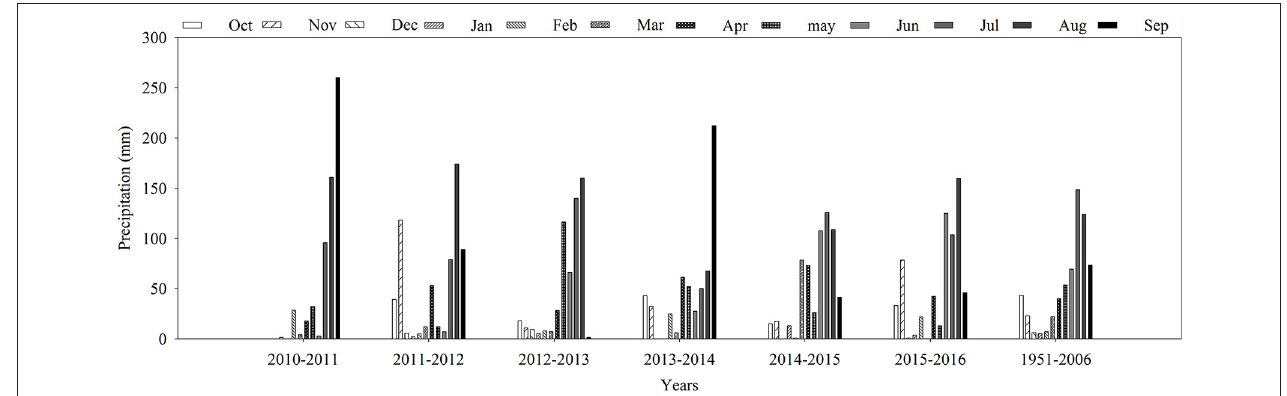
FIGURE 1 | Annual precipitation by month (October to September) during the six wheat-maize growing seasons from 2010–2011 to 2015–2016 and the corresponding monthly averages from 1951 to 2006 at the experimental